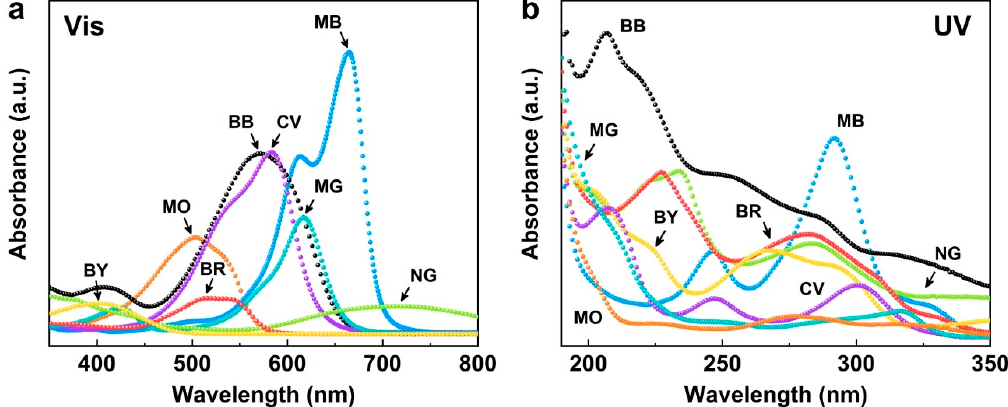
Figure 1. ( a ) Visible spectra of eight dyes (i.e., MO, MB, BB, BY, BR, CV, MG and NG) as organic pollutants ([Dye] 0 = 20 ppm, pH = 3.0). ( b ) Corresponding ultraviolet spectra of the eight dyes under the same conditions.